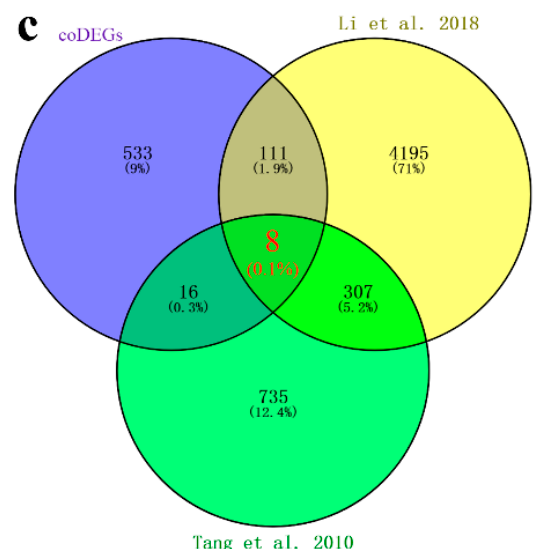
Figure 1. Identification of candidate genes associated with anther wall development by RNA-seq. ( a ) The number of di ff erentially expressed genes (DEGs) during microsporogenesis. ( b ) The quantity of common di ff erentially expressed genes (coDEGs) between HF and H1. ( c ) Venn analysis of coDEGs, DEGs in 02428-4x relative to 02428-2x [10] and DEGs preferentially expressed during meiosis [33]. Eight genes (red) overlapped among the three group DEGs.